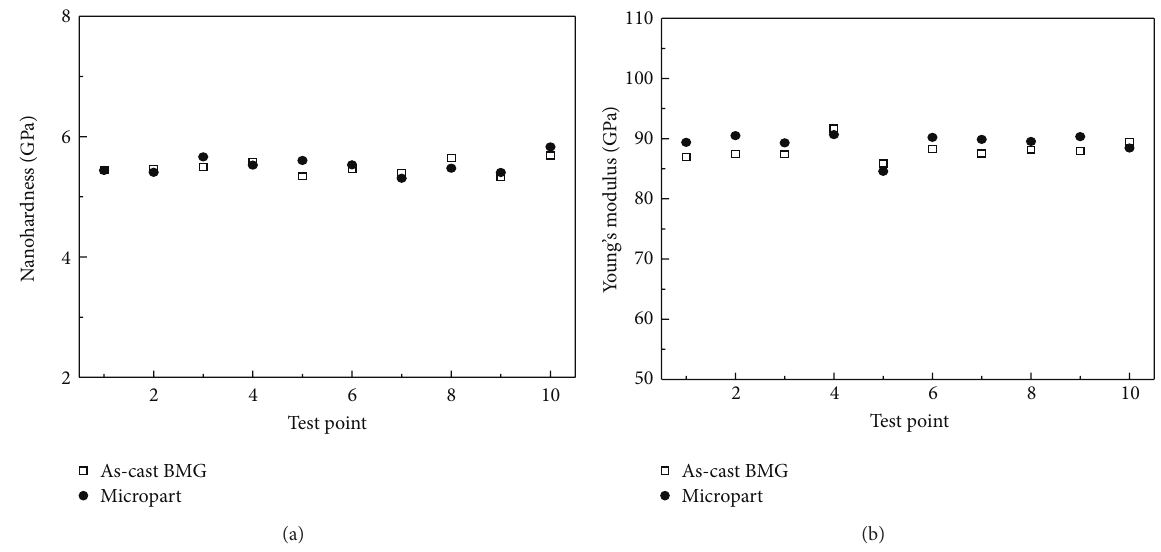
Figure 8: Nanohardness (a) and Young’s modulus (b) of the as-cast BMG feedstock and microgear.